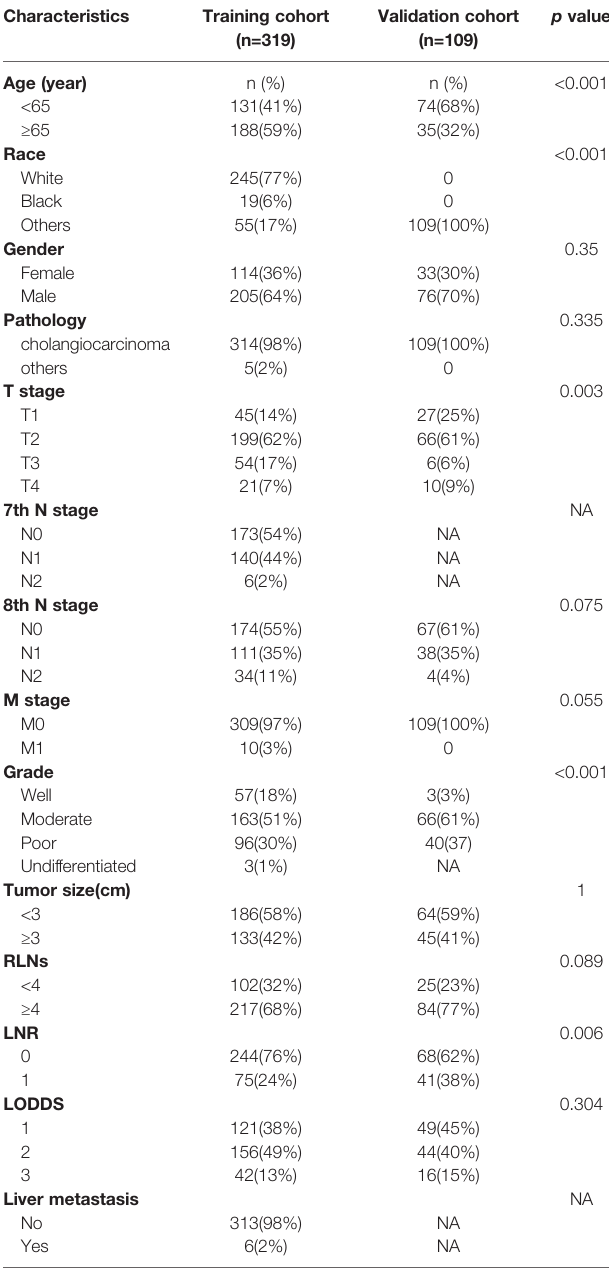
TABLE 1 | Demographics and characteristics of patients in Training and Validation